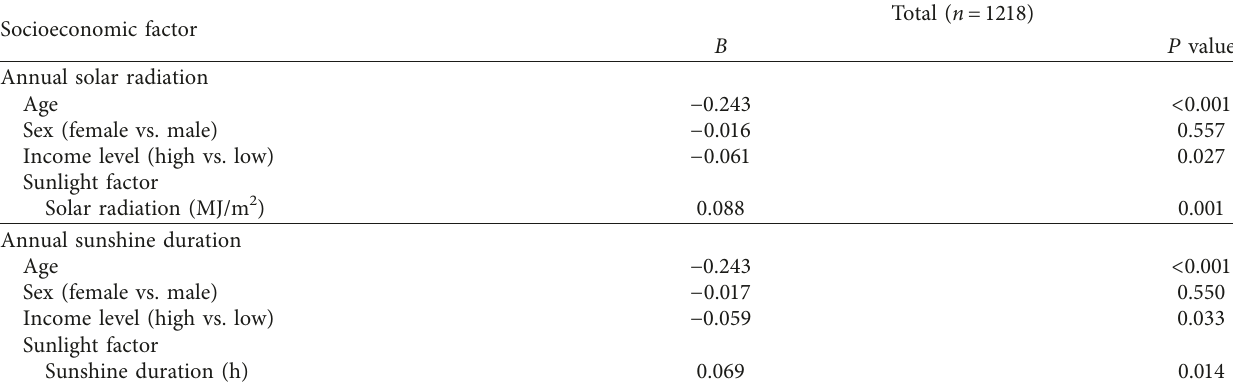
Table 2: Multiple linear regression analysis to assess the associations of different variables with mean spherical